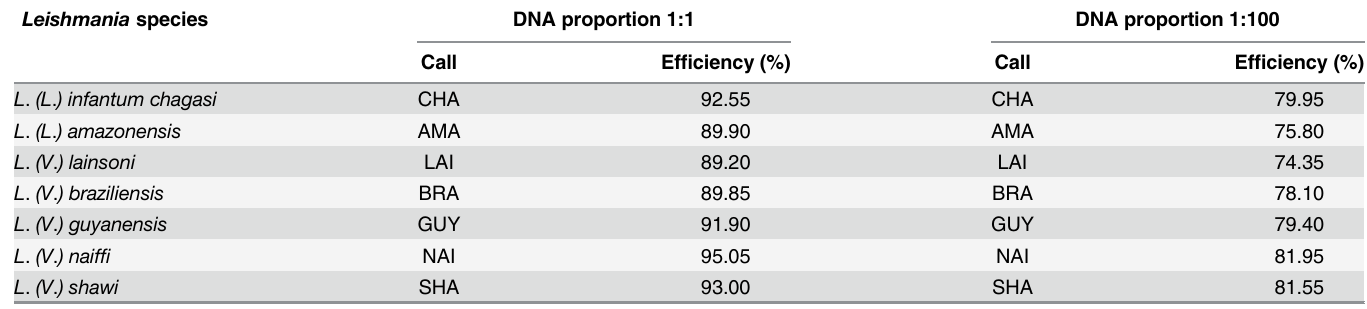
Table 2. Call efficiency obtained in the HRM analysis targeting the hsp70 gene of different Leishmania species in the presence of two different amounts of human reference (FMUSP-IOF-2016) DNA. The “ call ” column shows the identification name given by the software to the unknown samples based on names given to the reference samples; (CHA): L . (L . ) infantum chagasi ; (AMA): L . (L . ) amazonensis ; (LAI): L . (V . ) lainsoni ; (BRA): L . (V . ) braziliensis ; (GUY): L . (V . ) guyanensis ; (NAI): L . (V . ) naiffi and (SHA): L . (V . ) shawi . Each condition was tested in duplicate. Leishmania species DNA proportion